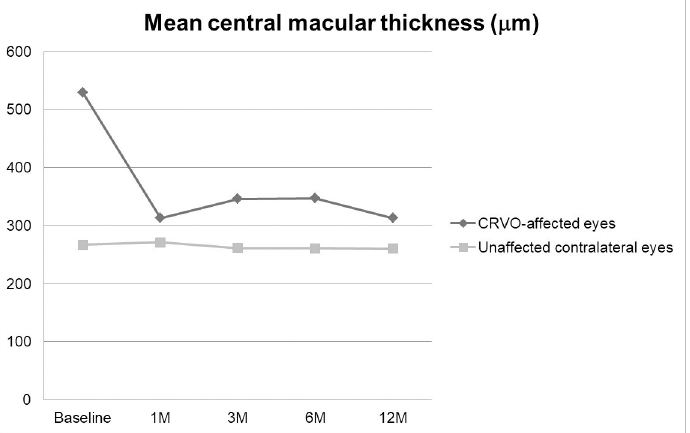
In the CRVO-affected eyes, the mean PCT was 146.7 ± 41.9 μ m (77.1 to 222.9 μ m) at baseline, and 106.5 ± 24.2 μ m (66.6 to 154.8 μ m) at 12 months (P < 0.001). The mean PCT of unaffected contralateral eyes was 129.8 ± 42.6 μ m (71.1 to 205.9 μ m) at baseline and 124.6 ± 39.7 μ m (70.8 to 198.5 μ m) at 12 months (P = 0.089). We did not observe any significant differences between